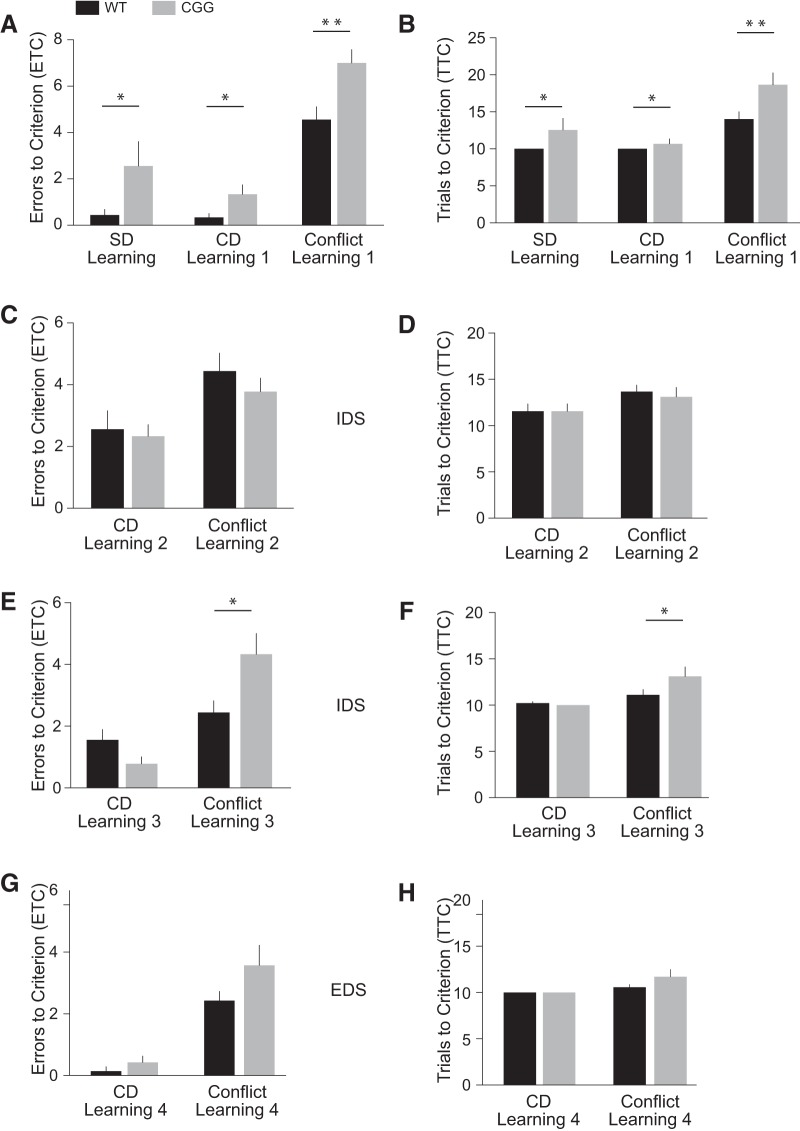
Cognitive flexibility is impaired in CGG animals. Numbers of ETC (A, C, E, and G) and TTC (B, D, F, and H) were recorded. A, B, In Phase 1, CGG animals were significantly impaired, in comparison to WT mice, in sessions SD learning, CD Learning, and Conflict Learning. C, D, CGG animals and WT animals performed similarly in Phase 2 sessions CD Learning 2 and Conflict Learning 2. E, F, In Phase 3, CGG and WT animals performed comparably in session CD Learning 3 but CGG animals displayed continued cognitive impairment in session Conflict Learning 3. G, H, In Phase 4, no significant differences were observed in the performances of CGG and WT animals in session CD Learning 4 and Conflict Learning 4. EDS, extradimensional shift; IDS, intradimensional shift. n = 9 for each animal group (CGG and WT).